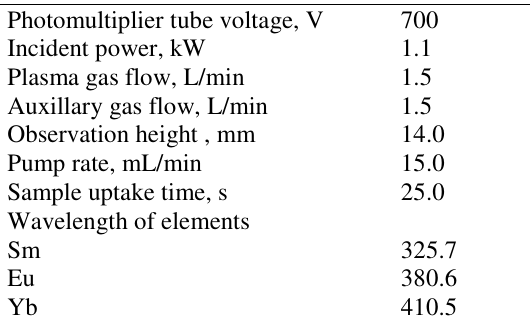
Table 3. Operating parameters of